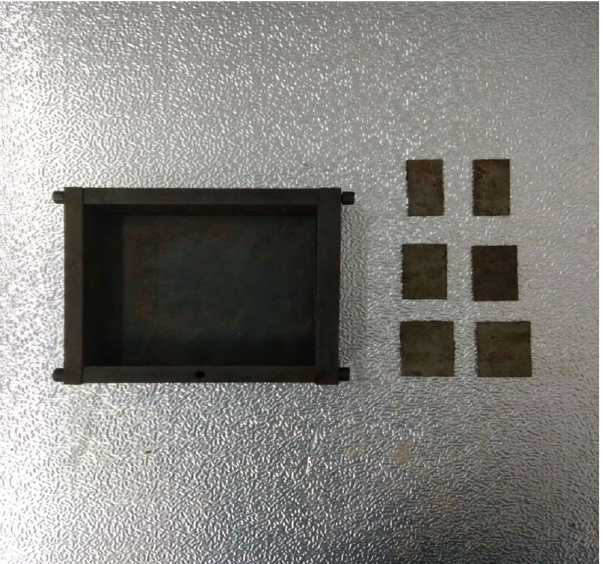
Figure 1. Mould for casting specimen and six steel sheets used to form cracks in specimen.